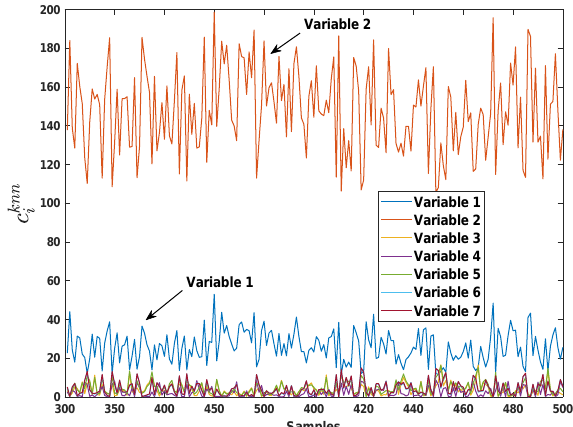
Figure 6. The variable contribution by kNN for case 2 of numerical simulation.